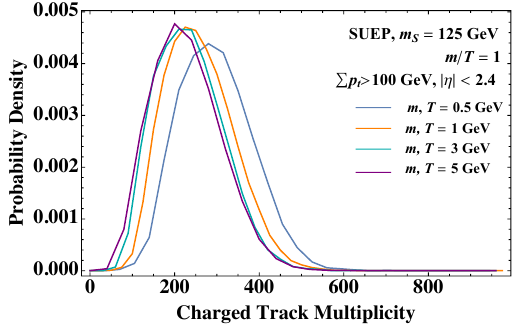
Figure 31 . Distributions of the charged track multiplicity when m=T = 1. For m = T values away from the QCD con(cid:12)nement scale, the distributions are very